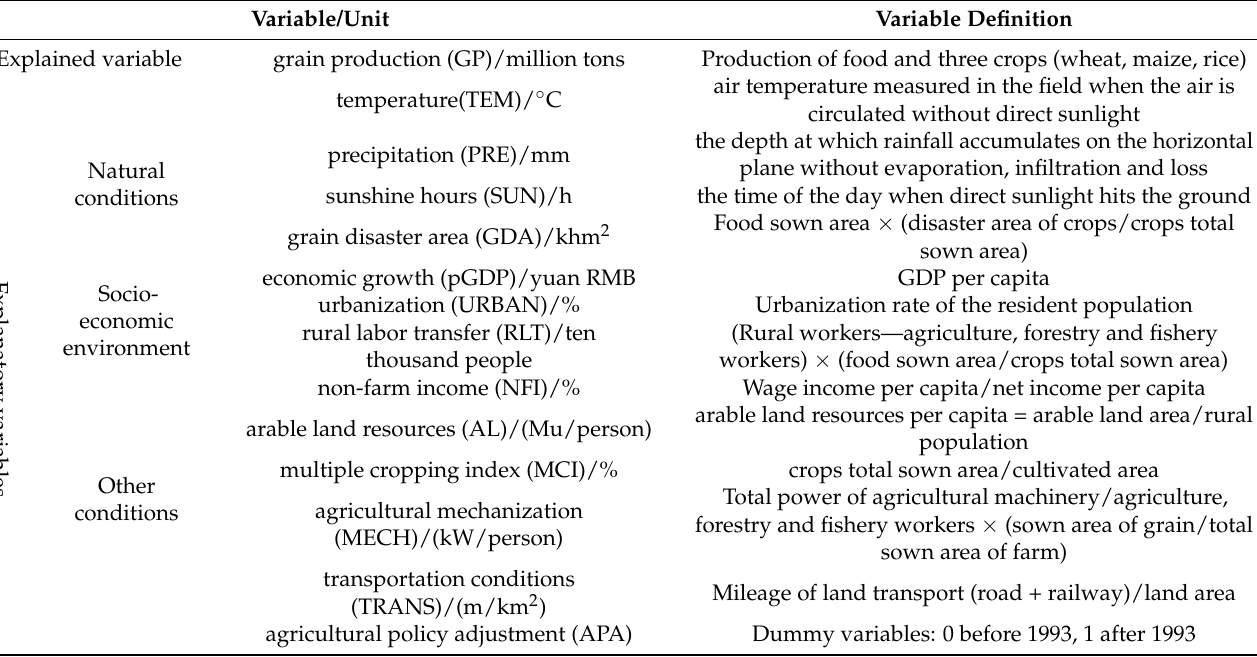
Table 1. Variables selection and indicators